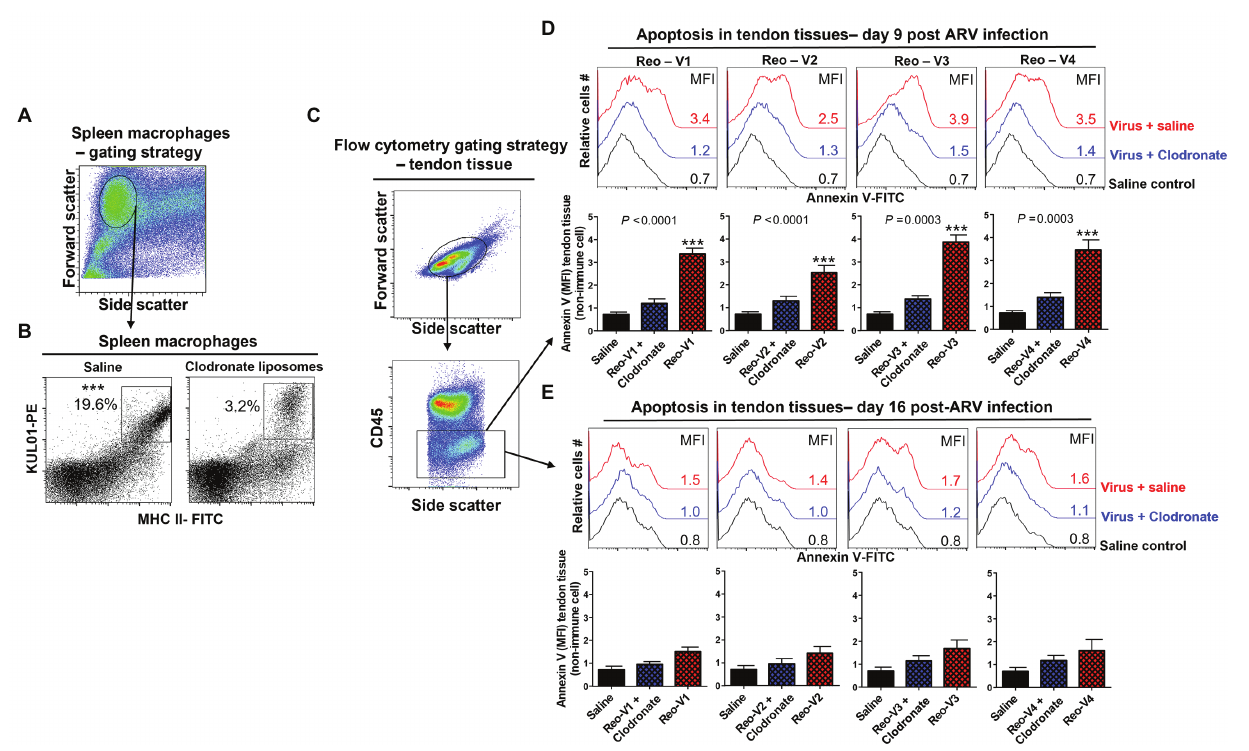
FIGURE 9 | Effect of depletion of macrophages with clodronate liposomes in birds followed by ARV infection [i.e., Reo-V1 (Cluster-5), Reo-V2 (Cluster-4), Reo-V3 (Cluster-2), or Reo-V4 (Cluster-6)] in the apoptosis of tendon tissue cells. (A,B) Flow cytometry analysis of percentage of MHC-II expressing macrophages in the spleen of saline or clodronate liposome treated birds. (C) Flow cytometry gating strategy of non-immune tendon tissue cells based on CD45 expression as immune cell marker. (D,E) Flow cytometry analysis of apoptosis of tendon tissue cells based on Annexin-V fluorescein binding in clodronate liposome treated followed by ARV infected, clodronate non-treated and ARV infected and saline control groups at day 9 (D) and day 16 (E) post-infection. Bar graphs: MFI of apoptotic tendon tissue cells at day 9 and day 16 post-infection based on three separate experiments. Asterisks indicate groups that were significantly different from other groups, *** p ≤